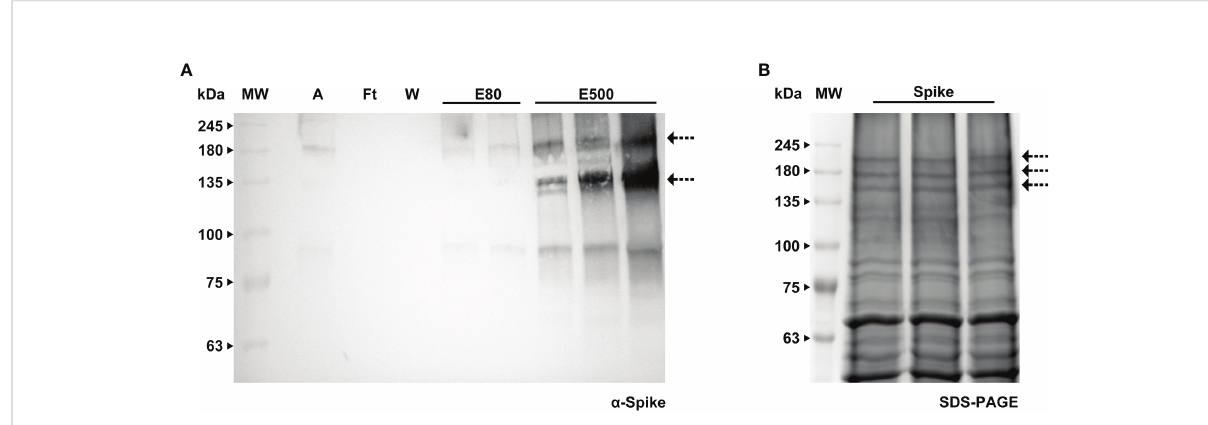
FIGURE 8 Puri fi cation of Spike protein by immobilized metal af fi nity using a HisTrap ™ High Performance column. (A) WB analysis of the imidazole eluted fractions of Spike protein with anti-Spike antibody, A - sample, Ft - fl ow through, W - wash, E80 - and E500 - eluted fractions. (B) Stained gel containing the concentrated eluted fractions after desalting; the bands corresponding to the Spike protein (indicated by an arrow) were further analyzed by MS.